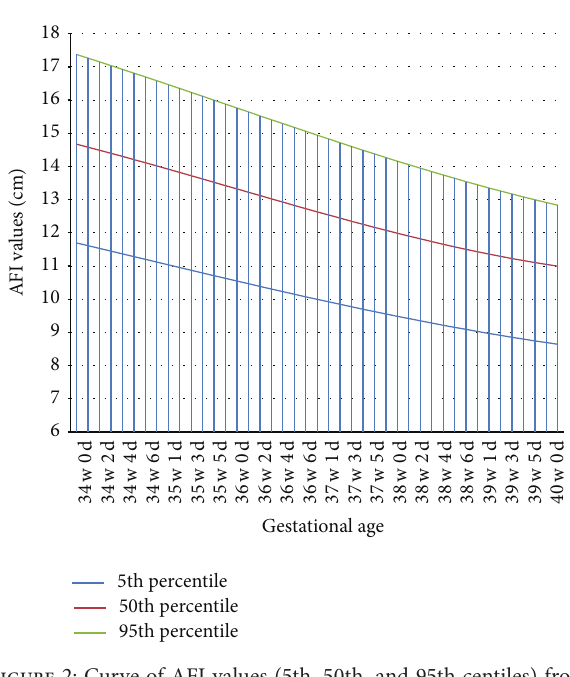
Figure 2: Curve of AFI values (5th, 50th, and 95th centiles) from 34 to 40 weeks following smoothing procedure from polynomial regression of 3rd